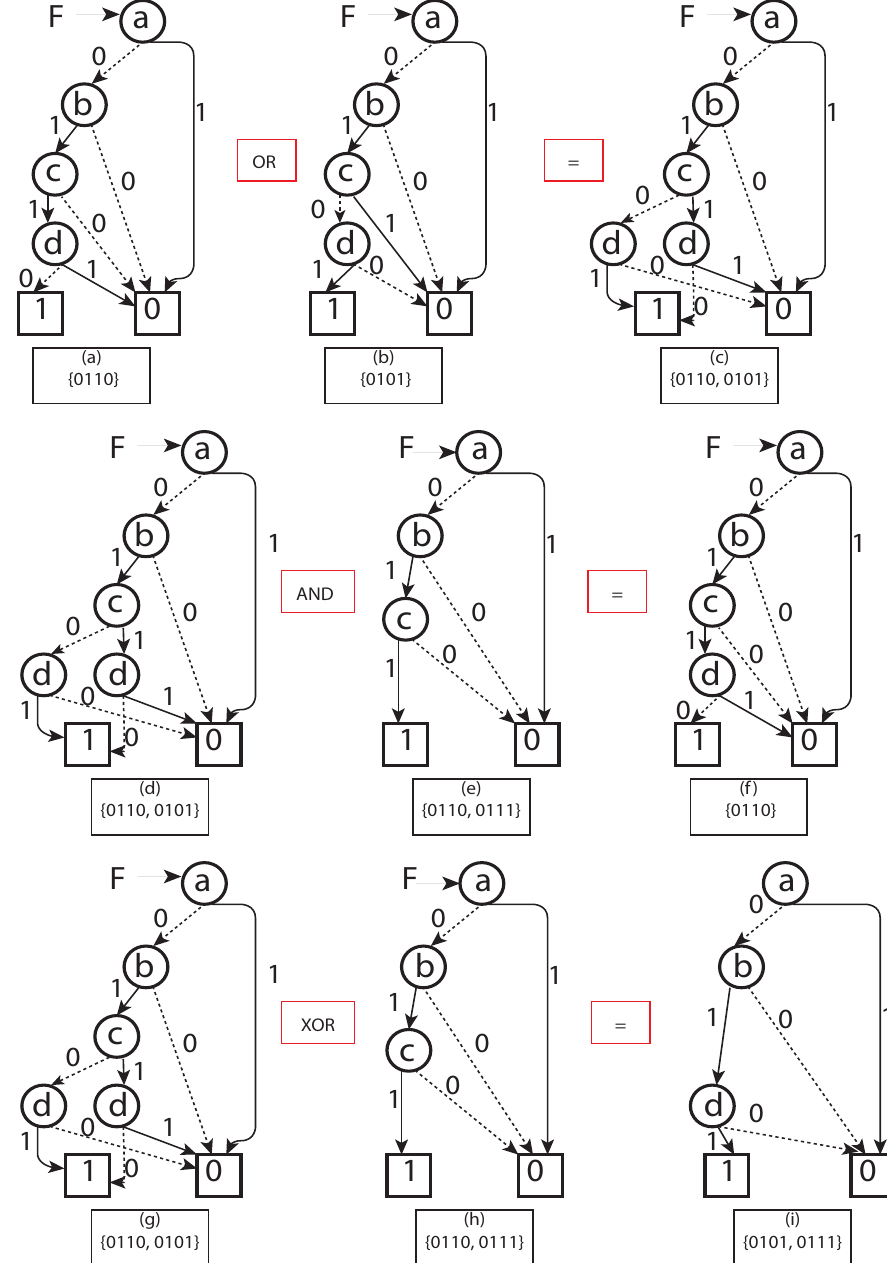
Figure 4. ( a – c ) BDD OR operation is equivalent to set union operation. ( d – f ) BDD AND operation is equivalent to set intersection operation. ( g – i ) BDD XOR operation is equivalent to a set symmetric difference